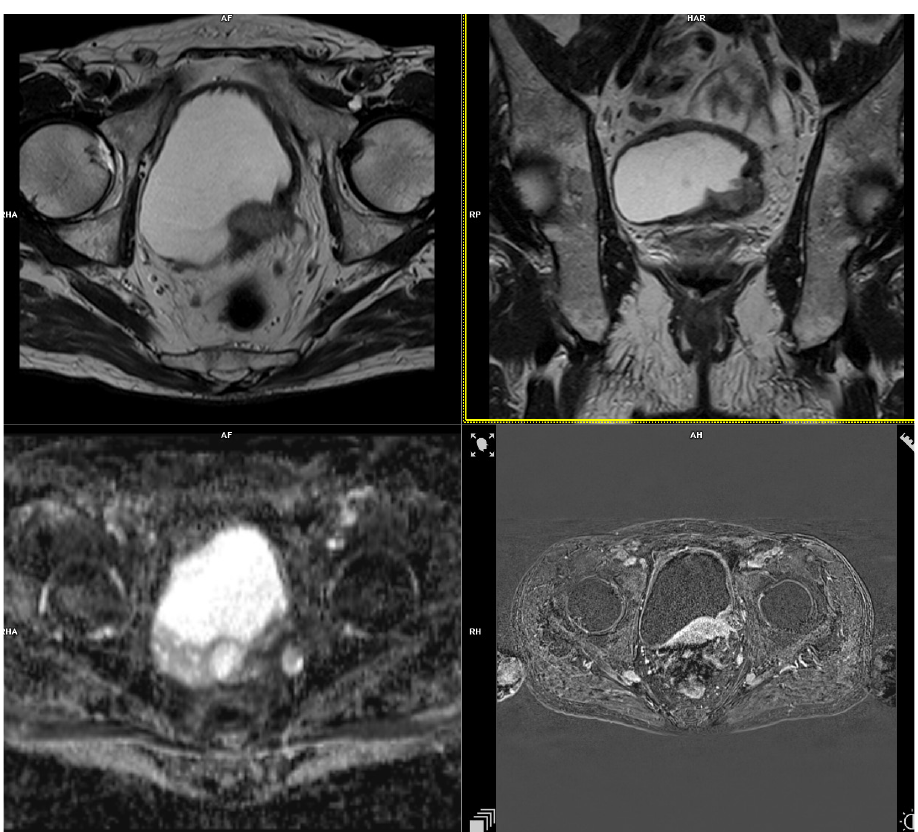
Fig. 4. VI-RADS 5 score